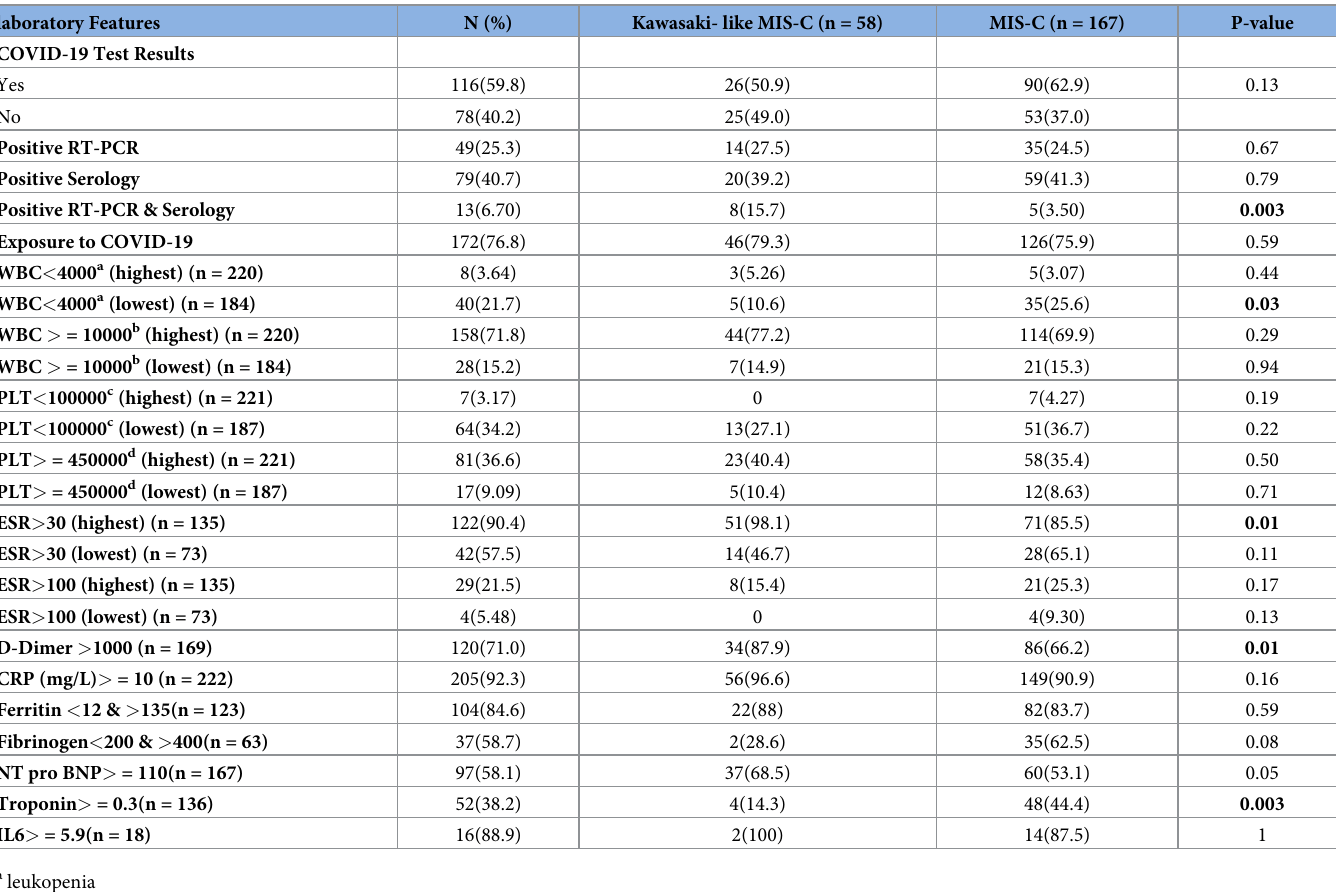
Table 6. Laboratory features in Kawasaki- like MIS-C and MIS-C